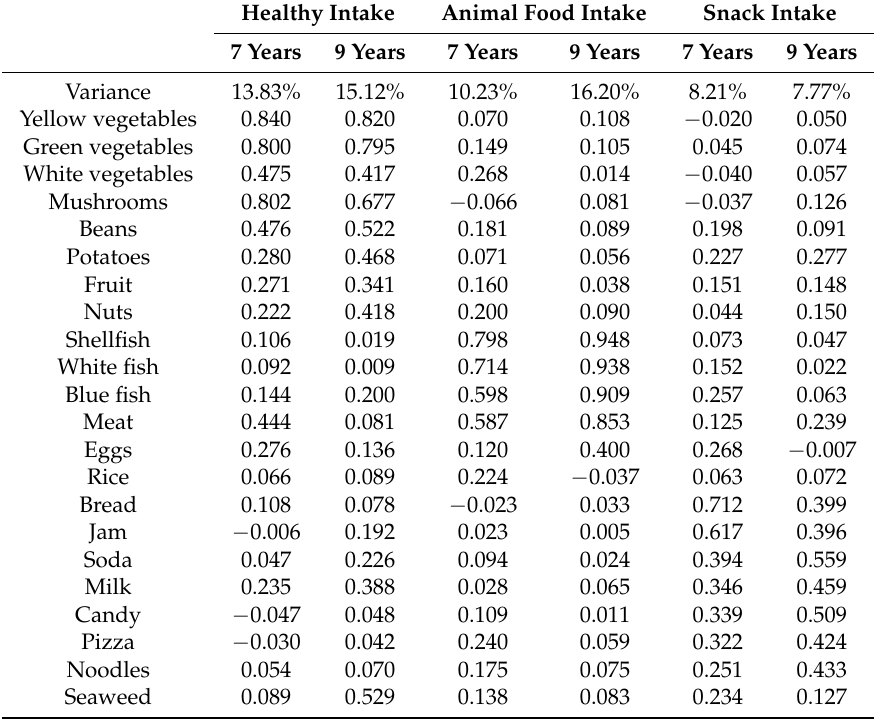
Table 1. Factor loading scores for the first three components derived from principal component